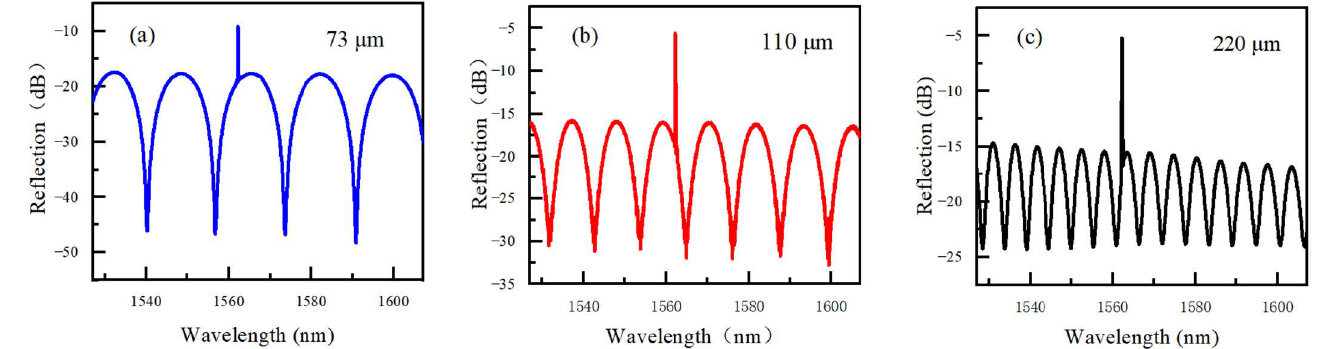
Figure 3. Spectra of the FPI probe with different hollow core fiber lengths of ( a ) 73, ( b ) 110 and ( c ) 220 μ m.